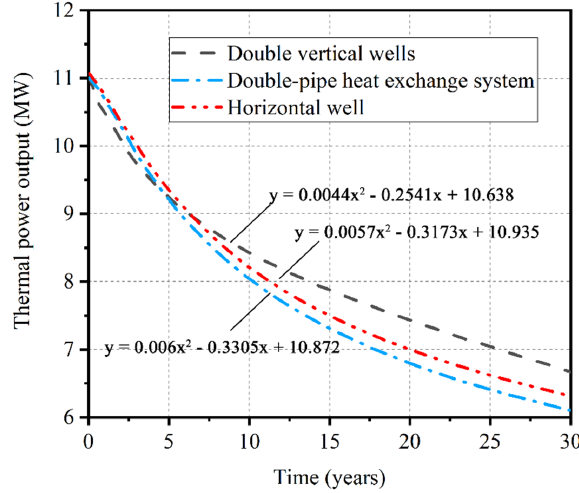
Figure 13. Thermal power output curve.